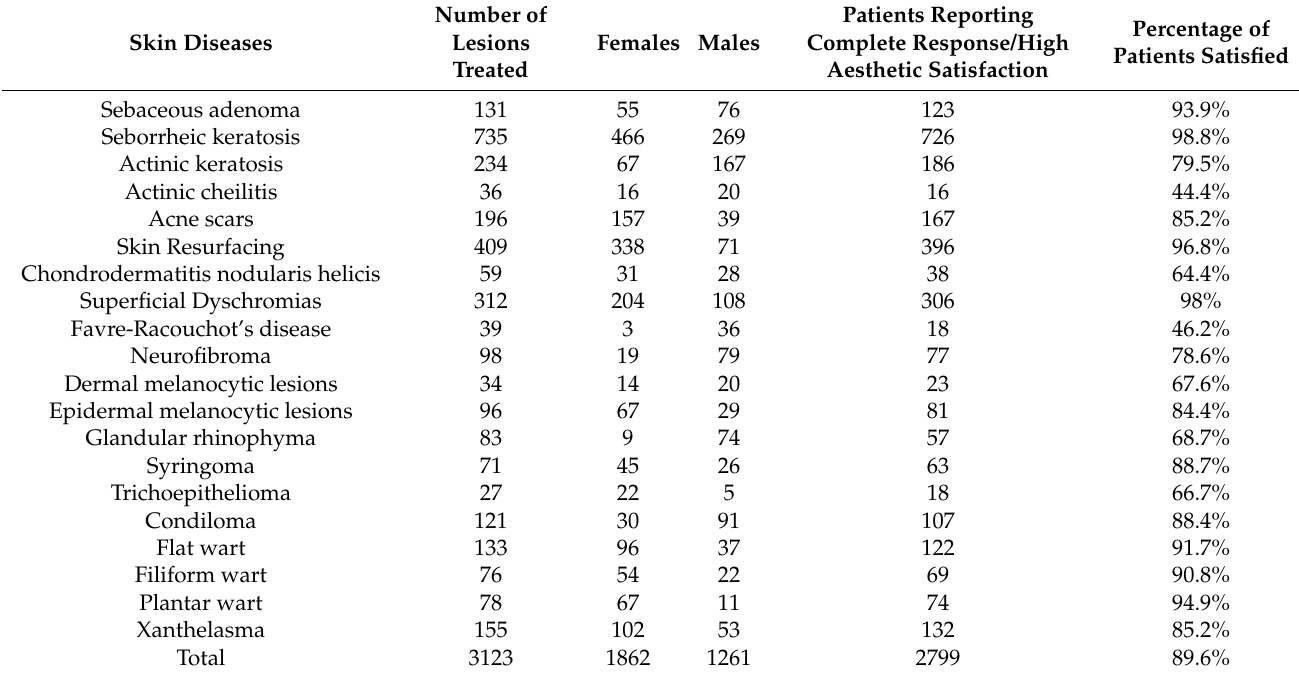
Table 1. Demographic data of included